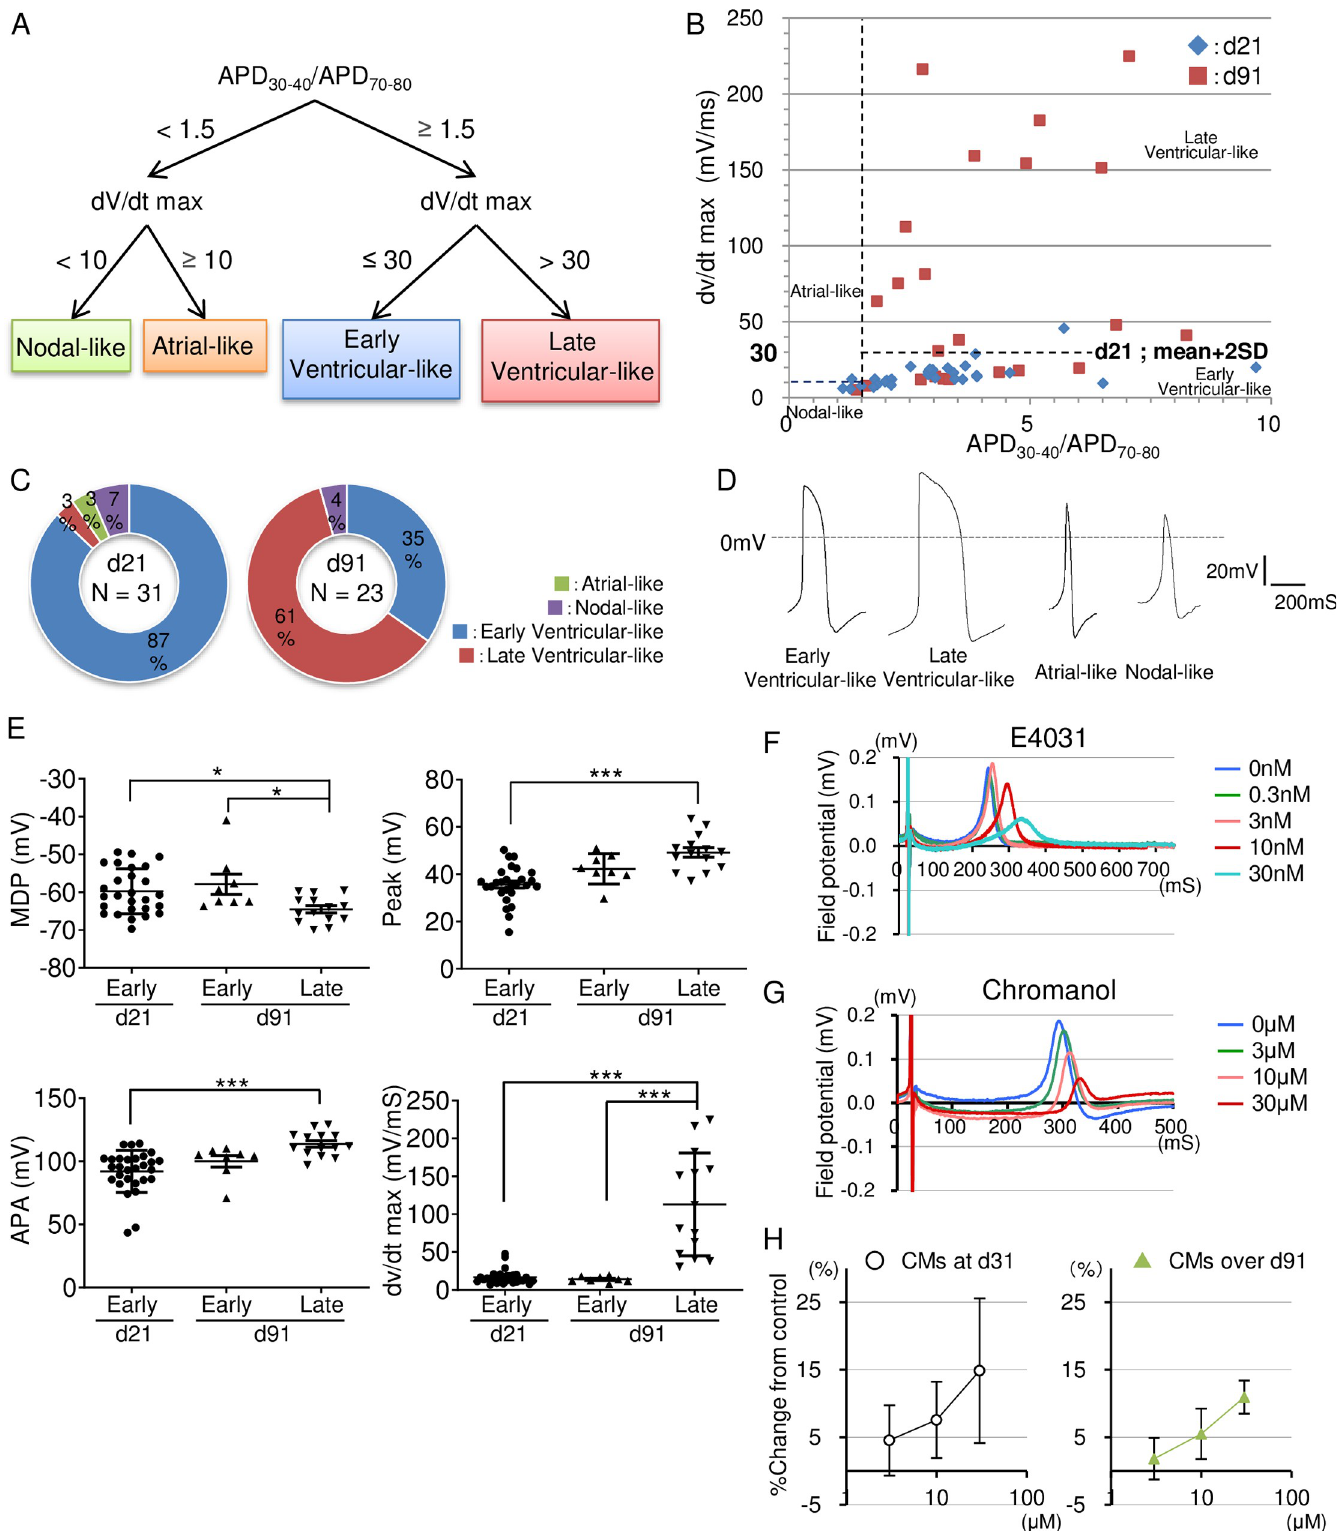
Fig 5. Electrophysiological characterization and maturation of CMs after long-term culture. (A) Criteria for CM subtype classification. (B) Relationship between APD30-40/APD70-80 ratio and dV/dt max on d21 and d91 CMs. (C) Pie charts illustrating the distribution of early ventricular-, late ventricular-, atrial- and nodal-like